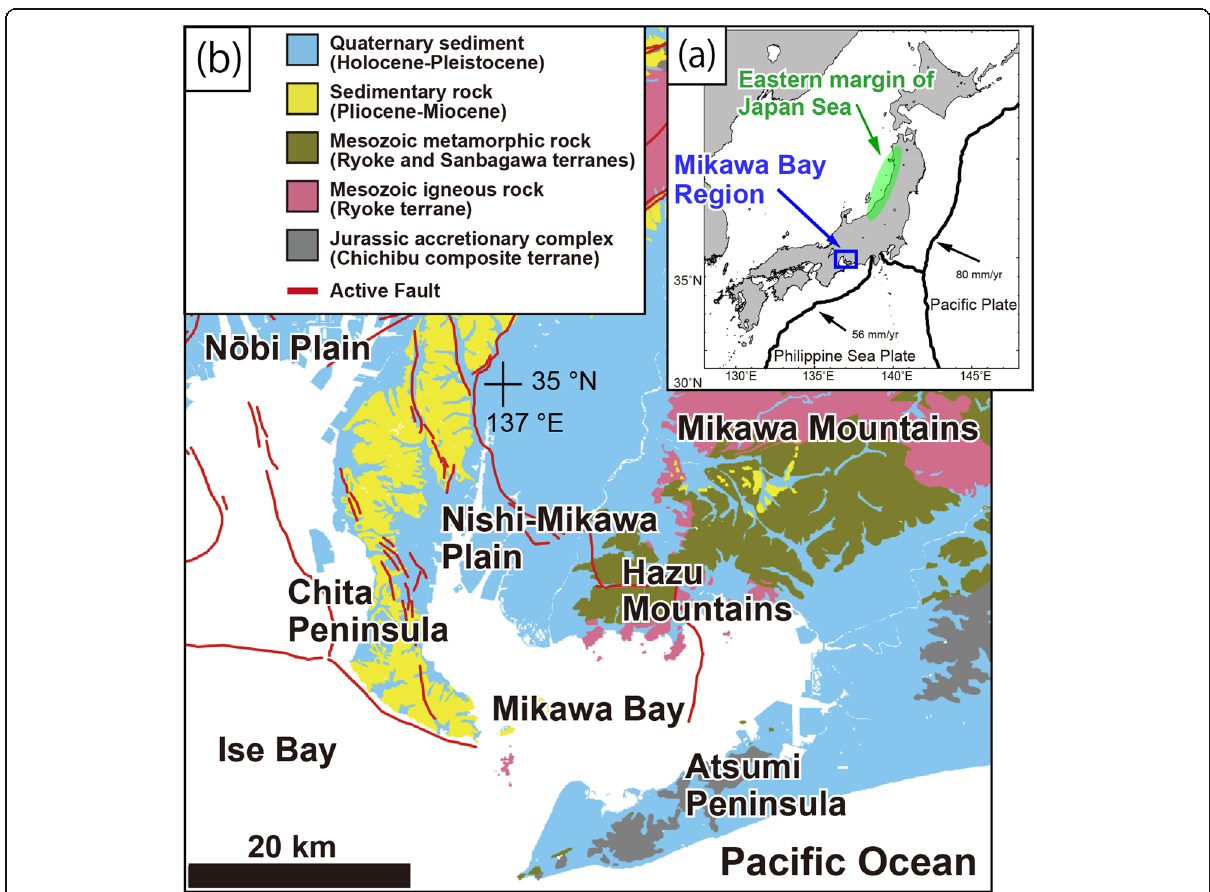
Fig. 1 Map showing the tectonic setting of the Japanese islands ( a ) and the geology of the study area ( b ) (National Institute of Advanced Industrial Science and Technology 2020b). a Thick black lines represent plate boundaries and black arrows represent relative plate motions (after Wei and Seno 1998). The blue rectangle represents the study area and the green shaded area is the eastern margin of the Japan Sea (see main text for